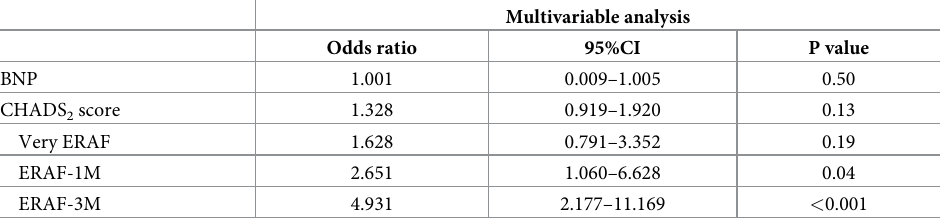
Table 4. Predictors of true AF recurrence after cryoballoon